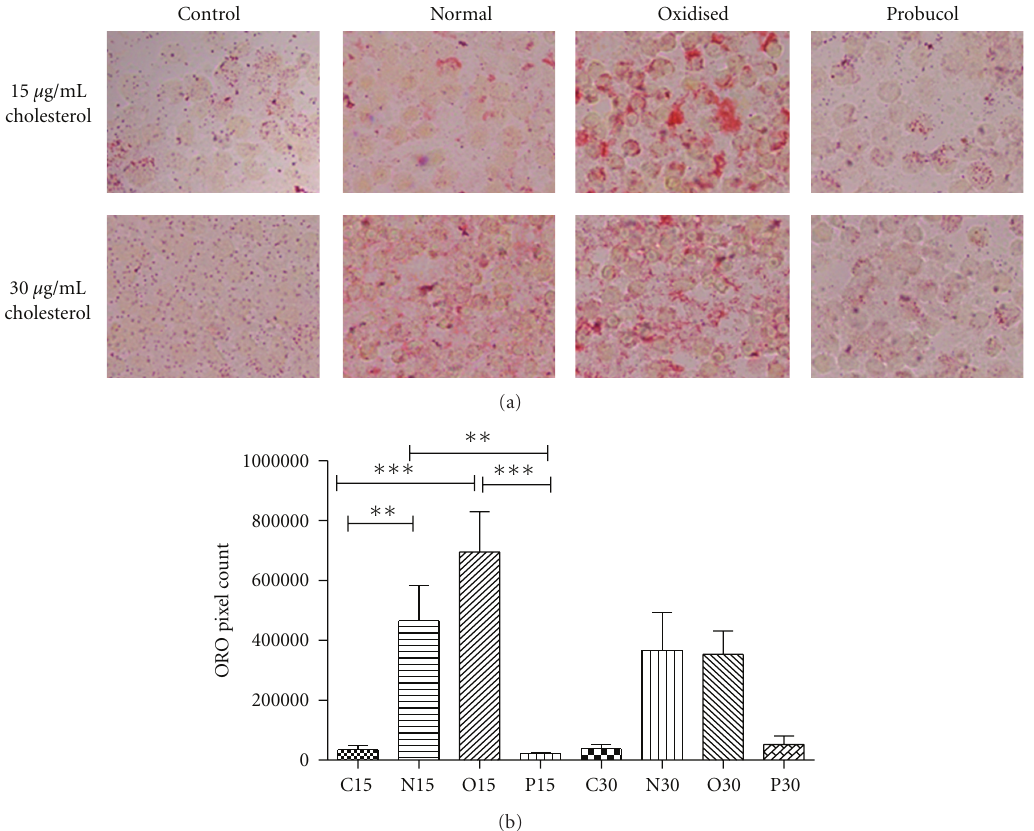
Figure 1: Uptake of native, oxidised, and probucol treated CRLP by primary human blood monocytes. Monocytes were incubated with CRLP at 37 ◦ C for 24h before cytospin fixation and oil Red O staining. (a) Representative images (captured at magnification × 40 and enlarged). (b) Volocity quantitation (pixel count analysis) from n = 6 monocyte isolations. Approximately, 700 cells were examined for each condition. C15/C30 control equivalent volume to 15/30 μ g/mL cholesterol, N15/N30, CRLP at 15/30 μ g/mL cholesterol, O15/O30 oxCRLP at 15/30 μ g/mL cholesterol, P15/P30 pCRLP at 15/30 μ g/mL cholesterol. ∗∗ P < 0 . 01, ∗∗∗ P < 0 . 001 analysis by one-way ANOVA and Bonferroni’s